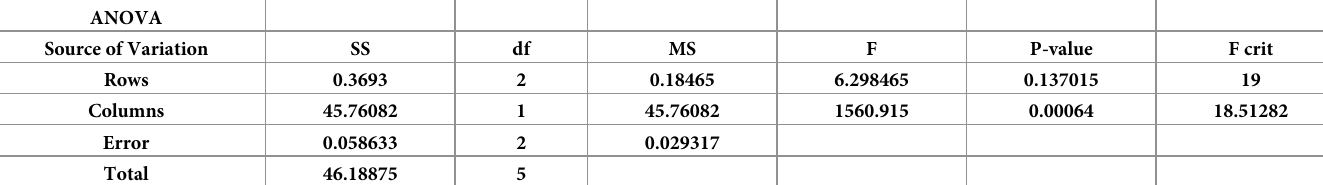
Table 4. ANOVA results of the variable effects on the response recovery of rHBsAg by immunomagnetic and immunoaffinity matrixes. ANOVA Source of Variation SS df MS F P-value F crit Rows Columns